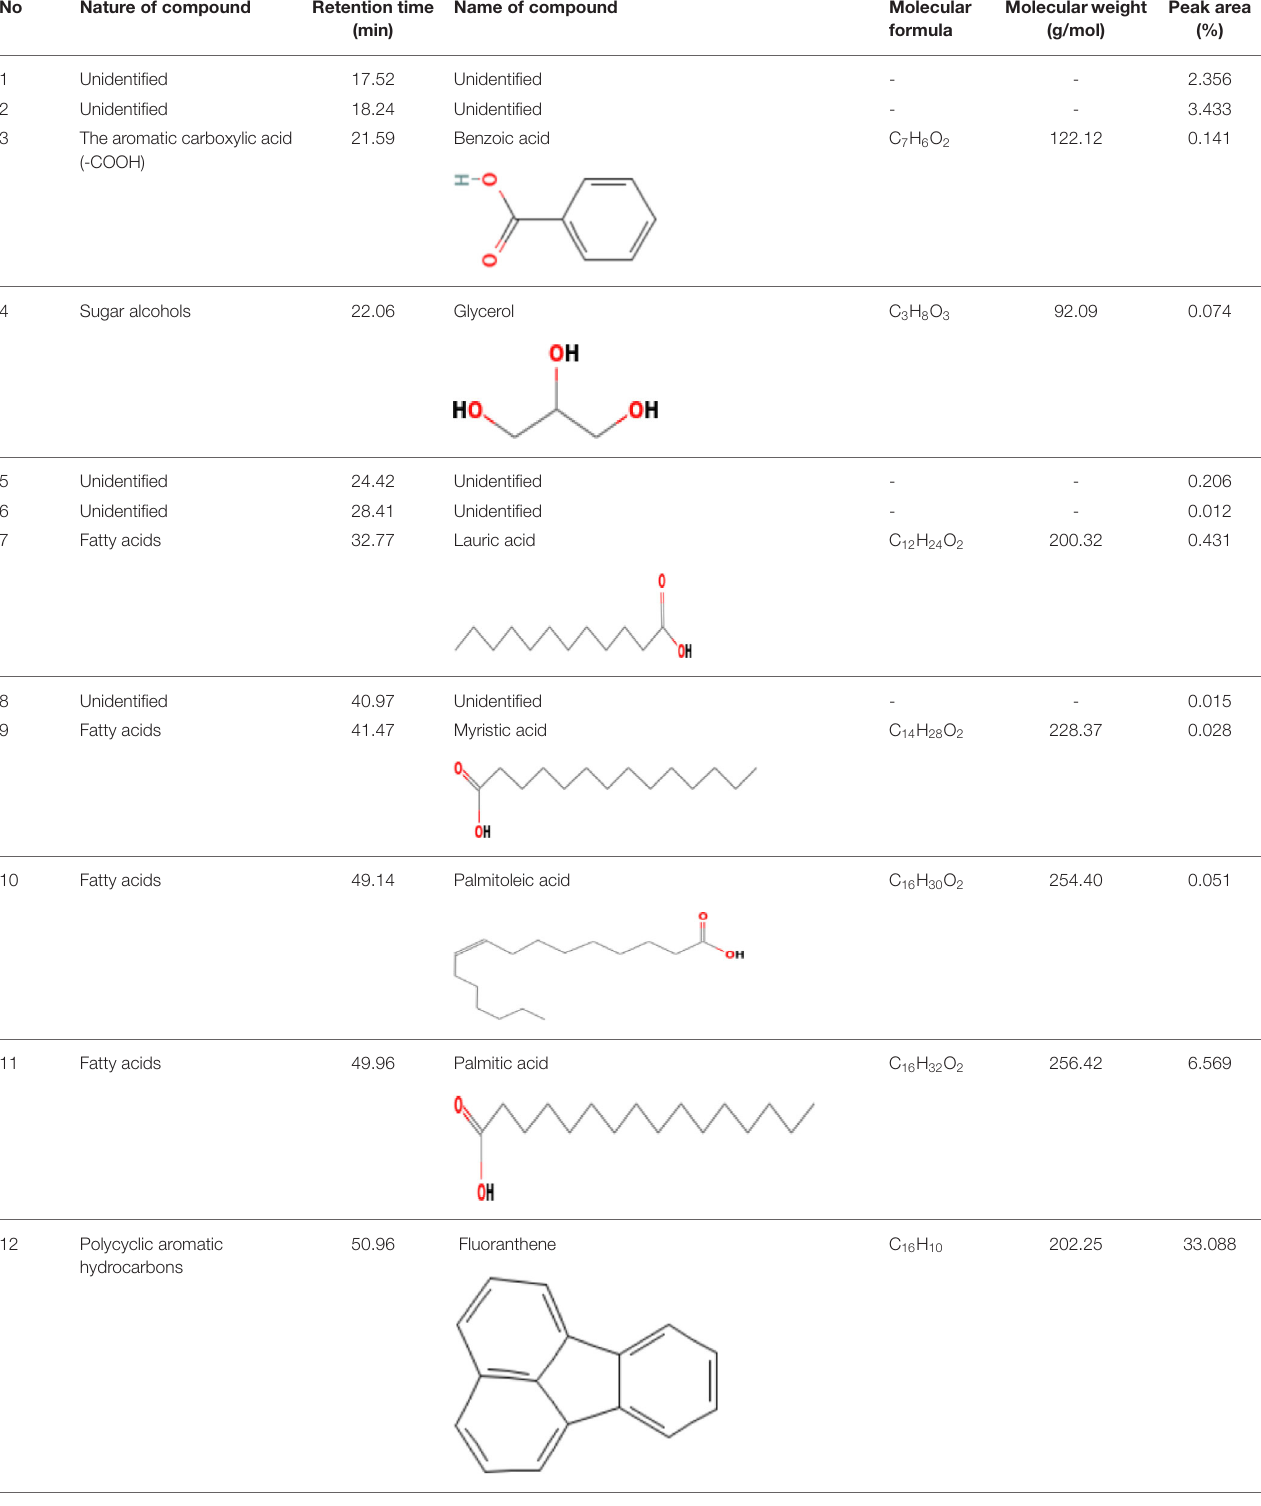
TABLE 1 | Gas chromatography-mass spectrometry (GC-MS) analysis of Moringa oleifera seed